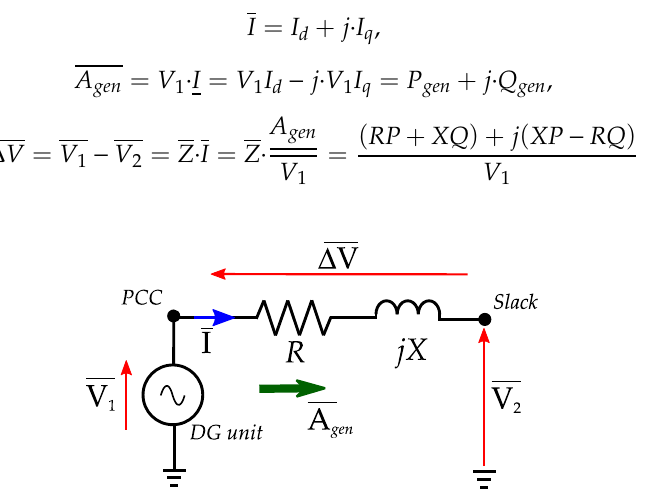
Figure 4. Electric circuit of a typical distribution line connecting a DG unit.